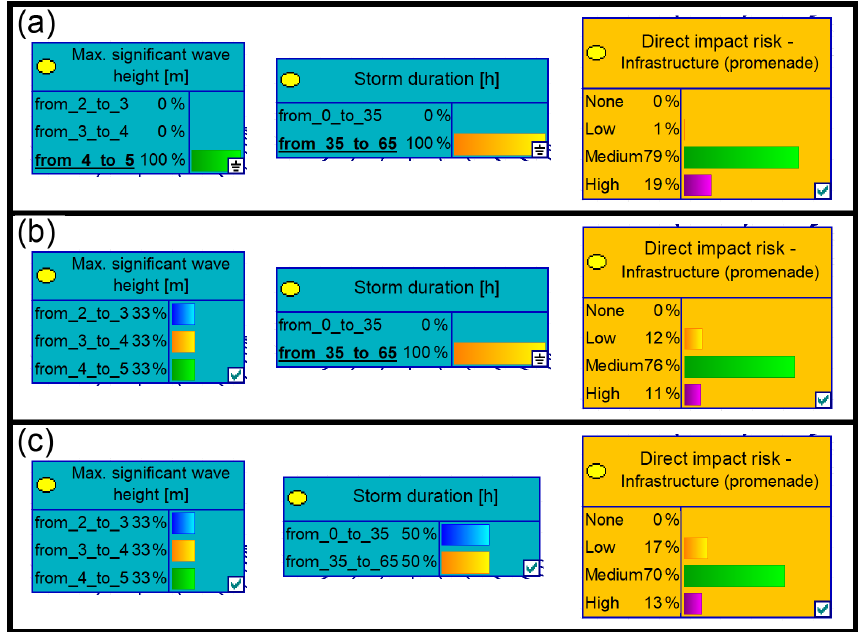
Figure 10. Example of result integration in the Bayesian-based decision network. Combinations of Hs and duration to obtain erosion risk at infrastructures in Tordera Delta. Total water level is constrained to “current” and direction to eastern incoming